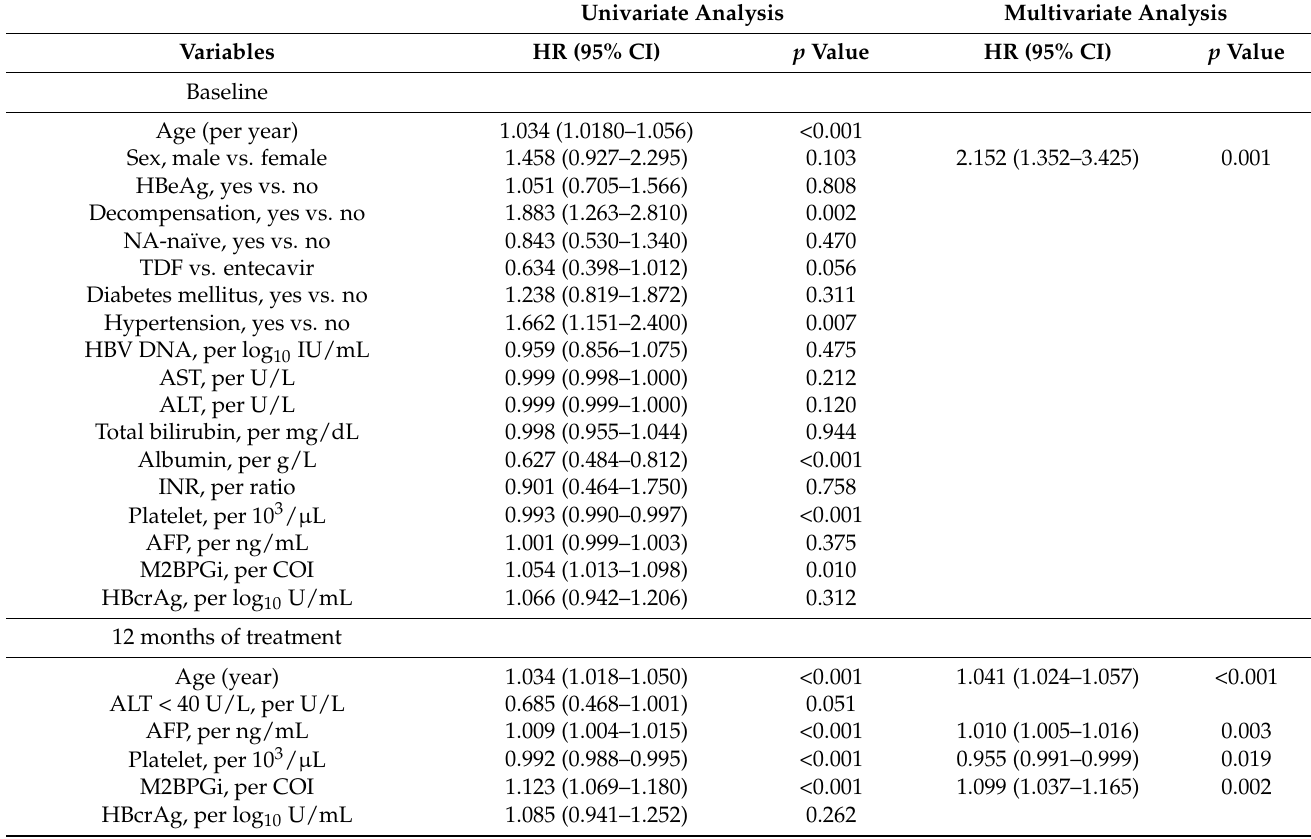
Table 2. The risk predictors of hepatocellular carcinoma in the development cohort.